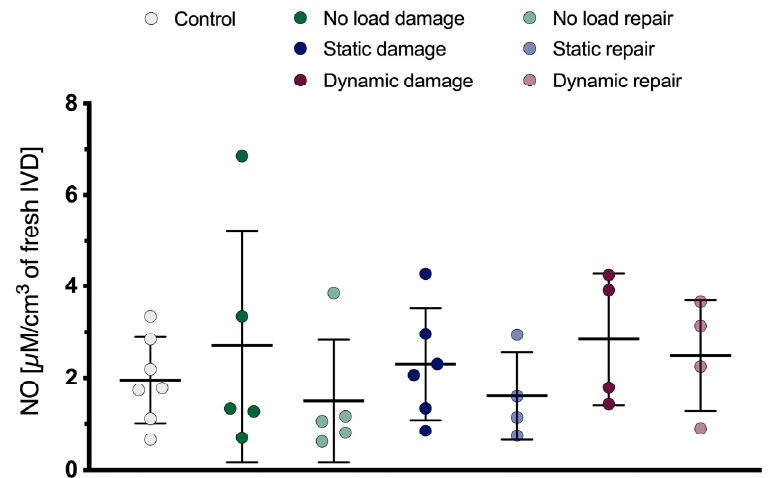
Figure 6. Amount of NO released from the IVDs into the culture medium relative to the IVDs’ volume after dissection from a bovine tail. Mean ± SD, n = 4–7.